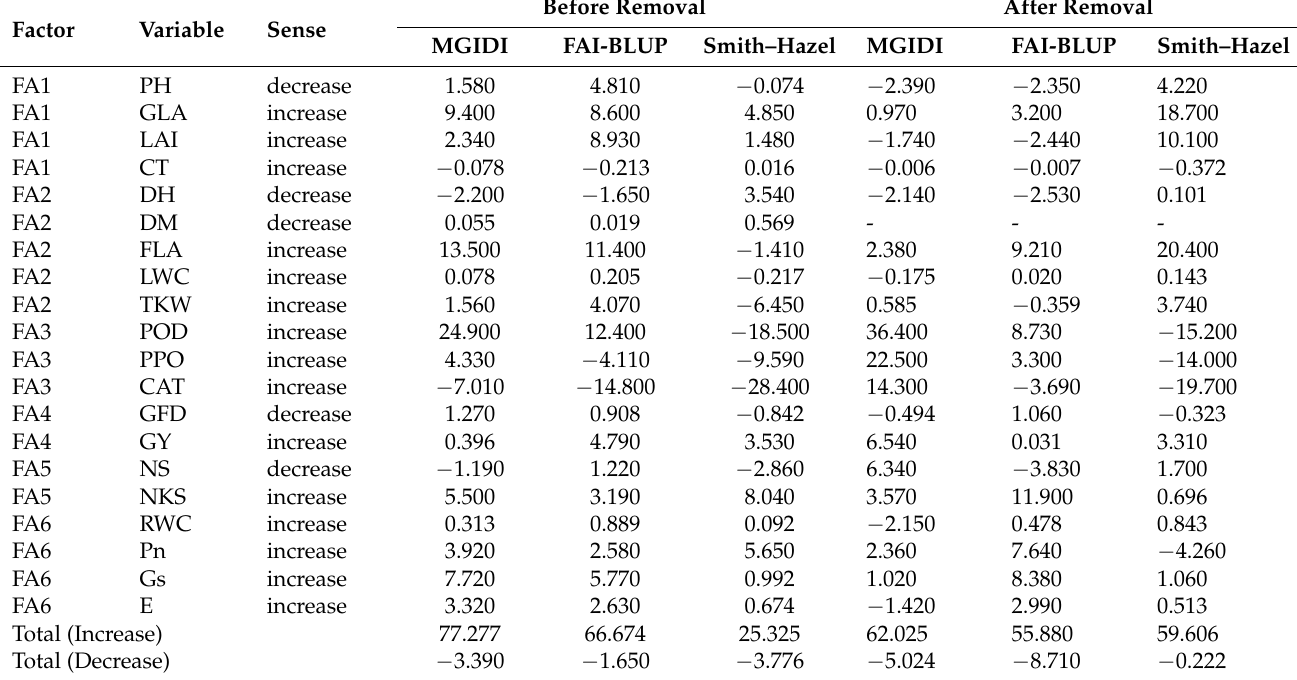
Table 5. Predicted genetic gains for the MGIDI, FAI-BLUP, and Smith–Hazel indices before and after the removal of variable